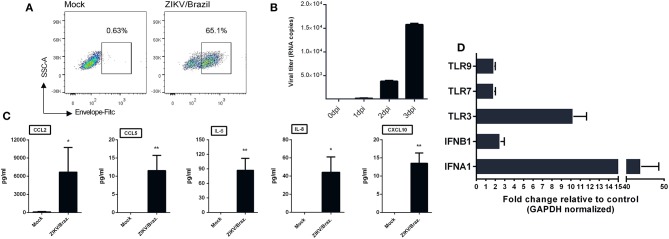
ZIKV infection of human neuroblastoma cells results in cytokine release. (A) SH-SY5Y cells were infected with ZIKV/Brazil (MOI = 1), harvested at 2 days post-infection (dpi), stained with anti-flavivirus envelope (E) protein 4G2 and anti-mouse conjugated with FITC, and analyzed by flow cytometry (FACS). (B) SH-SY5Y cells were infected with ZIKV/Brazil (MOI = 1) and the supernatants were processed for viral RNA extraction and qRT-PCR at different days post infection. (C) SH-SY5Y cells were infected with ZIKV/Brazil (MOI = 0.5), supernatants were harvested at 3 dpi and cytokines/chemokines production levels were quantified by Cytometric Bead Array. (D) RT-qPCR results of selected genes related to type-I IFN response. Relative expression (fold change) of mRNA transcripts are shown from infected SH-SY5Y cells (analyzed at 48 h after infection) relative to control group. Mock—cell not infected. Data are represented by mean ± SD. Figures are representative of three independent experiments, performed in triplicate (n = 3). *p < 0.05, **p < 0.01, by unpaired Student's t-test.